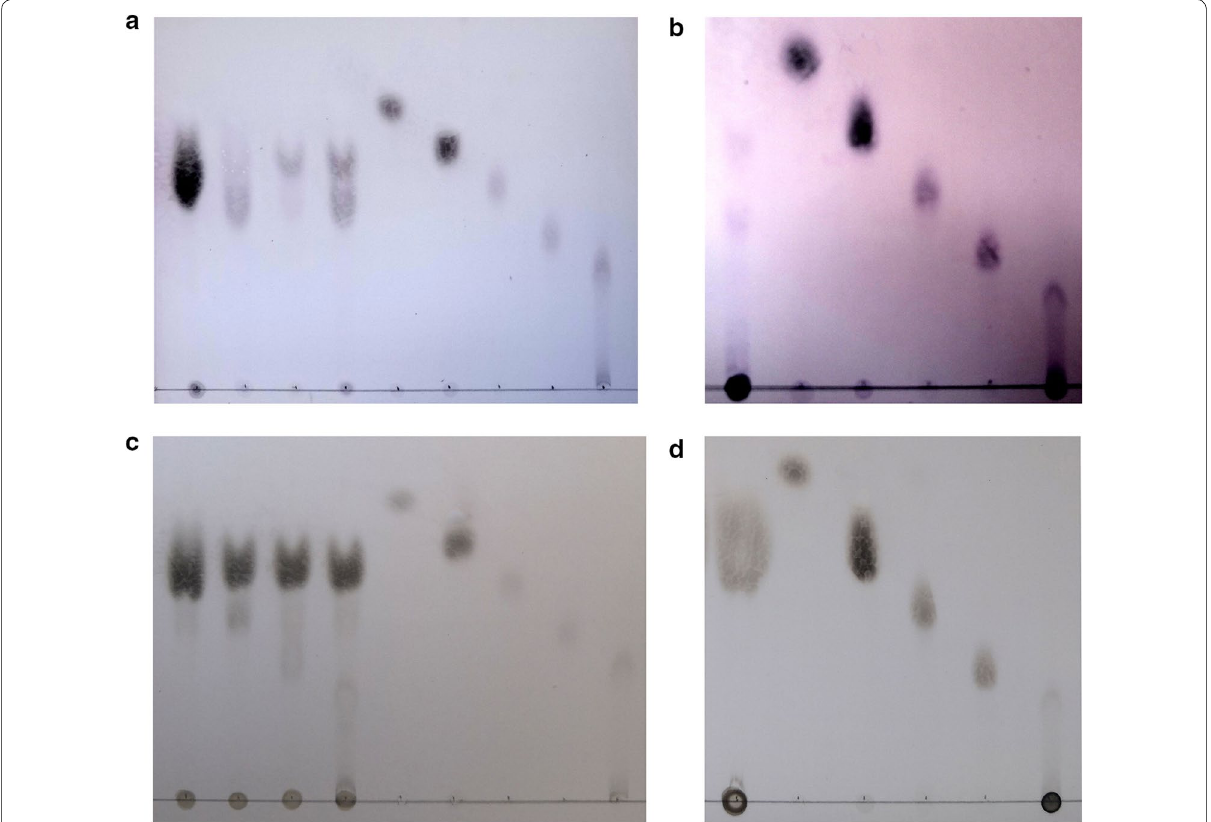
Fig. 5 Thin-layer chromatography of the enzymatic hydrolysis product. Hydrolysis of cellooligomers by Cel5A ( a ) and Cel9A ( c ), the lanes from left to right are followed by cellobiose hydrolysate, cellotriose hydrolysate, cellotetraose hydrolysate, cellopentose hydrolysate, and standard glucose, cellobiose, cellotriose, cellotetraose and cellopentose. Hydrolysis of CMC by Cel5A ( b ) and Cel9A ( d ), the lanes from left to right are followed by CMC hydrolysate, glucose, cellobiose, cellotriose, cellotetraose and